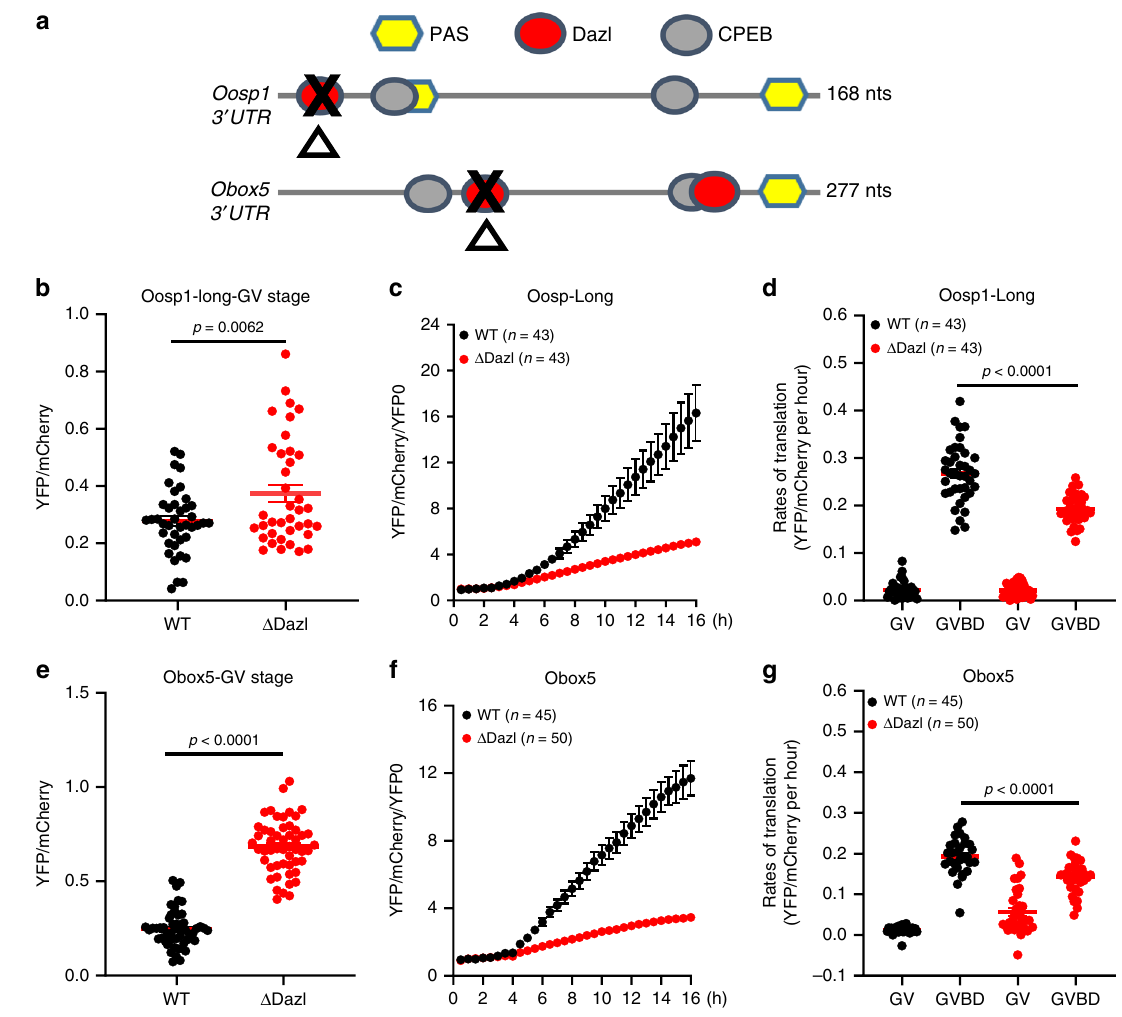
Fig. 8 Translation of Oosp1 and Obox5 reporter is dependent on the presence of a DAZL binding element. Wild type Oosp1 3 ′ UTR or Obox5 3 ′ UTR as well as constructs with mutations in the DAZL binding site were injected along with mCherry -polyadenylated mRNA into GV stage oocytes. After overnight pre-incubation to allow mCherry signal to plateau, oocytes were released in cilostamide-free medium and signals recorded. YFP signal were corrected by the level of co-injected mCherry signal. Black symbols: control; Red symbols: mutant constructs. Experiments were repeated three times and the number of oocytes recorded is reported. a Scheme of the Oosp1 and Obox5 3 ′ UTR and position of the PAS, putative CPEB1 and DAZL-binding elements. Mutagenesis of the putative DAZL-binding element was performed as detailed in “ Methods ” section. A red oval represents the DAZL consensus sequence in the 3 ′ UTR of Oosp1 and Obox5 . A black cross indicates the mutated DAZL-binding consensus sequence. b , e The effect of DAZL-binding element mutation on Oosp1 (unpaired two tailed t -test, p = 0.0062) or Obox5 (unpaired two tailed t -test, p < 0.0001) translation in GV stage. Rates of reporter accumulation were calculated for each GV-arrested oocyte and plotted as individual dots. Mean and SEM values were calculated from three independent experiments. c , f Mutation of DAZL-binding element on 3 ′ UTR of Oosp1 or Obox5 decreases translation of reporters during oocyte maturation. YFP signals were corrected by the co-injected mCherry signal. Each time point was normalized to the fi rst YFP:mCherry ratio. d , g Rates of YFP-Oosp1 or YFP-Obox5 reporter accumulation compared to a wild type reporter calculated from c , f (unpaired two tailed t -test, p <